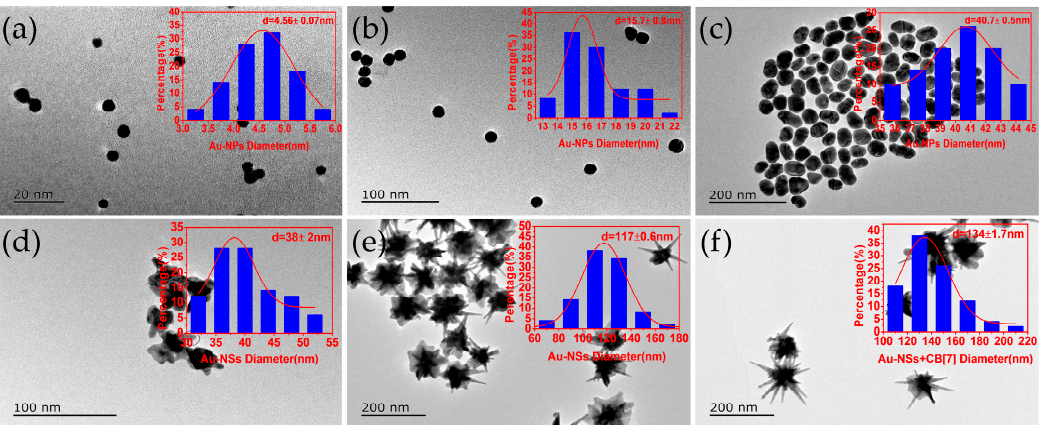
Figure 1. Typical transmission electron microscopy (TEM) images of synthesized gold nanoparticles in this work: ( a ) 4 nm gold nanospheres (Au ‐ NPs); ( b ) 16 nm Au ‐ NPs; ( c ) 40 nm Au ‐ NPs; ( d ) 40 nm Au ‐ NSs; ( e ) 117 nm Au ‐ NSs; ( f ) 134 nm Au ‐ NSs + CB[ 7 ] (cucurbit [7 ]uril). The microstructures were characterized by TEM (JEM ‐ 2010 UHR, JEOL, Tokyo, Japan).